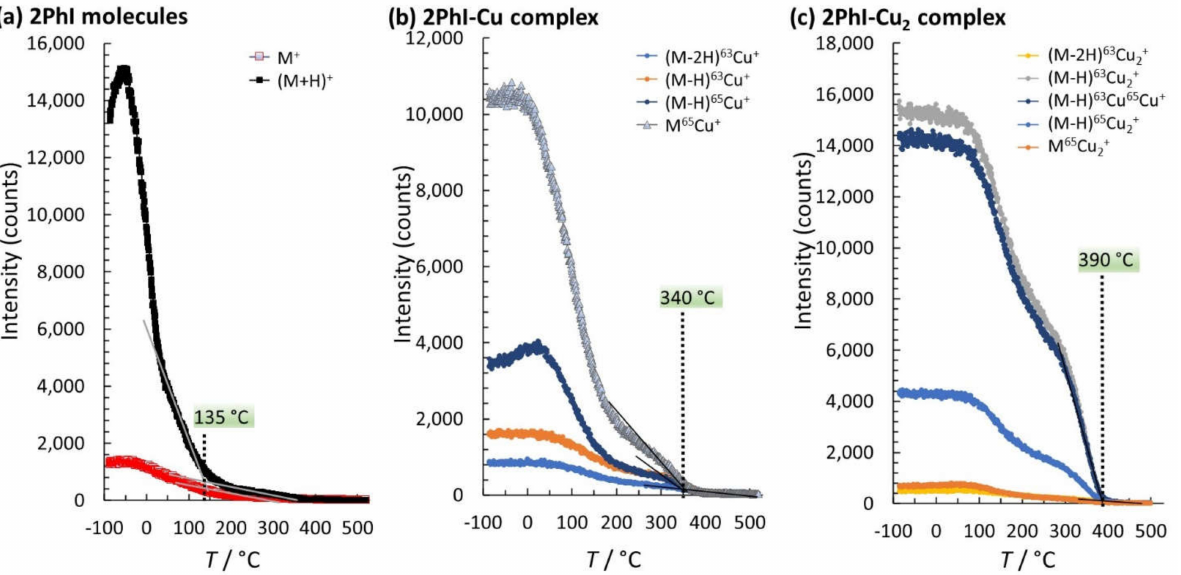
Figure 8. The cooling and heating experiment associated with the ToF-SIMS measurements of the signals characteristic of ( a ) 2PhI molecules, ( b ) organometallic complex with one Cu ion (2PhI-Cu), and ( c ) organometallic complex with two Cu ions (2PhI-Cu 2 ). These species were formed on 2PhI-treated